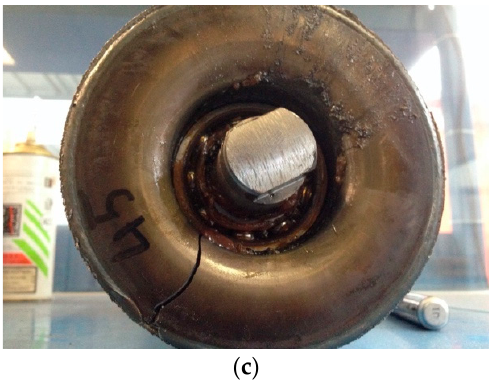
Figure 4. Lack of penetration at the weld root ( a ), a detail of the crack through the welded zone ( b ) and typical roller failure ( c ).